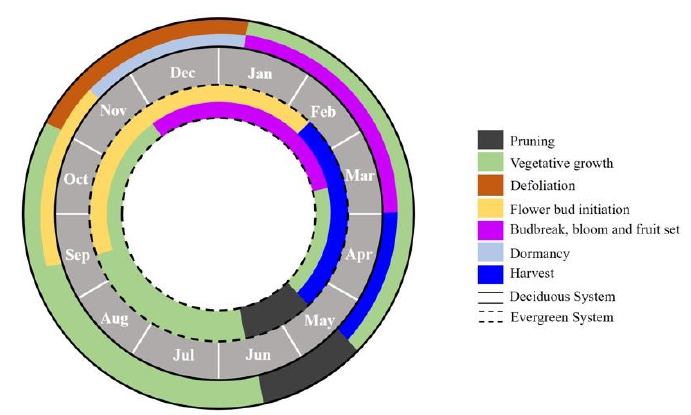
Figure 4. Timing comparison of the different stages of fruit production for southern highbush blueberry under an evergreen production system (inner ring) and a deciduous production system (outer ring) in Florida.